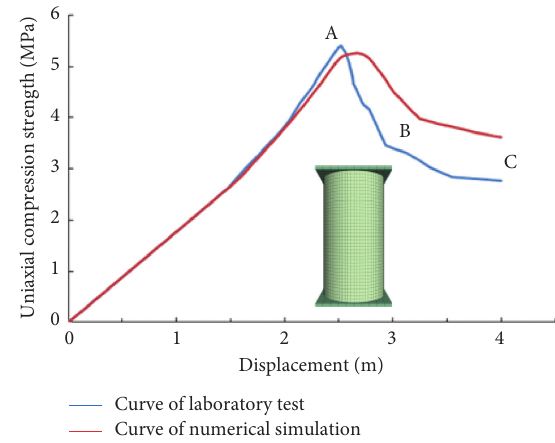
Figure 5: Contrast diagram of the stress-strain curve between numerical simulation and laboratory test. Table 1: Parameters of the soft coal seam for the strain-softening Mohr–Coulomb.